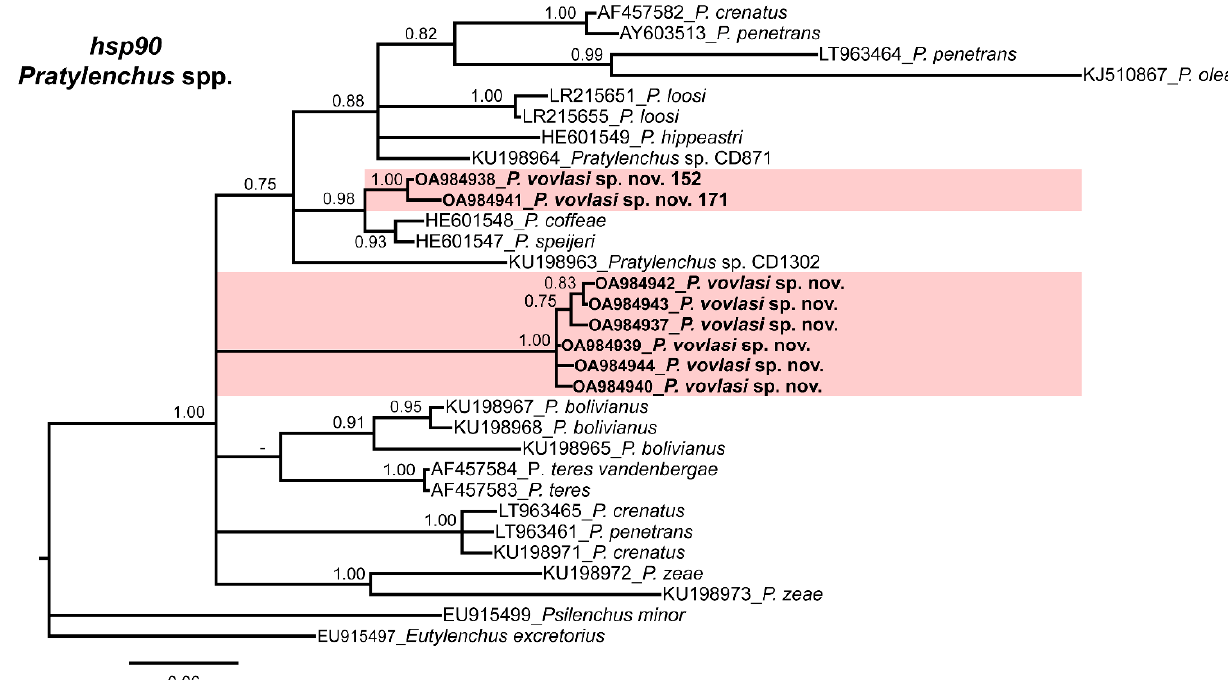
Figure 4. Phylogenetic relationships of Pratylenchus vovlasi sp. nov. within the genus Pratylenchus . A Bayesian 50% majority-rule consensus tree as inferred from the hsp90 sequence alignment under the general time-reversible model of the sequence evolution with a correction for invariable sites and a gamma-shaped distribution (GTR + I + G). Posterior probabilities more than 70% are given for appropriate clades. Newly obtained sequences in this study are in bold letters. Scale bar = expected changes per site.